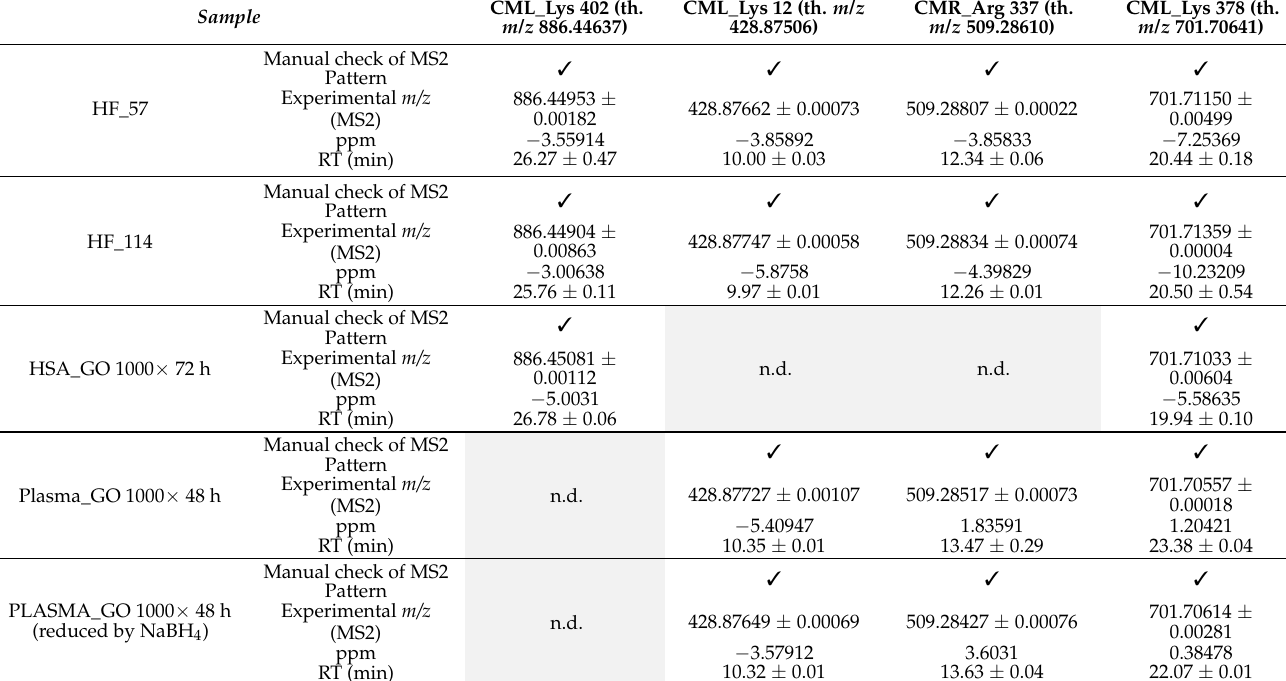
Table 3. Summary of the results obtained by the manual inspection of the fragmentation profile and the retention time in in-vitro-produced AGE/ALE adducts on HSA, confirming such modifications selected as protein adducts characteristic of the pathological condition (HF). For each sample, the following are reported: (i) the information related to the overlapping fragmentation profile, (ii) the m / z of the precursor fragmented, and (iii) the retention time, for each adduct searched. n.d. not